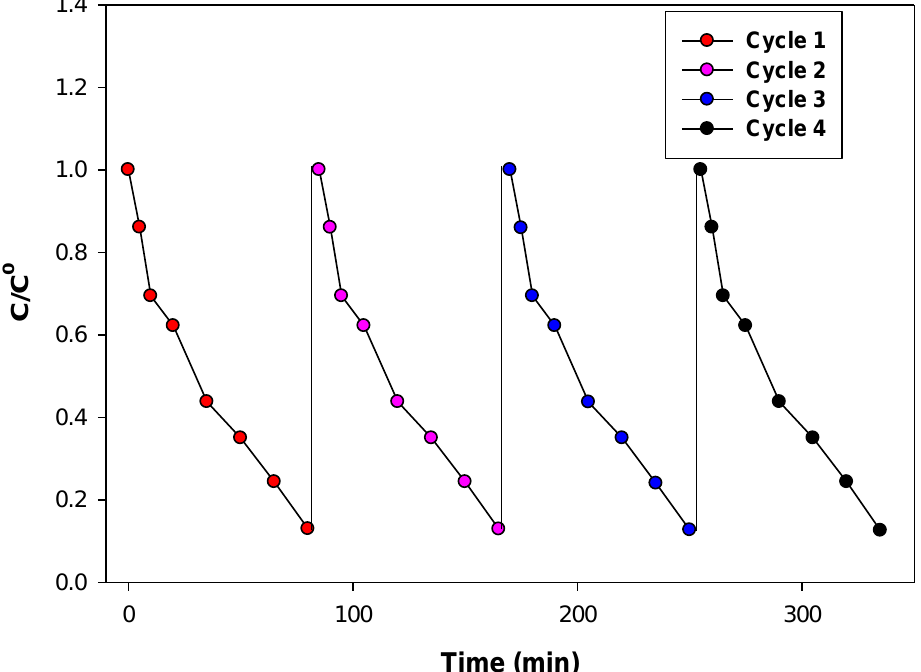
Figure 10. Reusability of ZnO-GO nanocomposite for the decolorization of methylene blue.